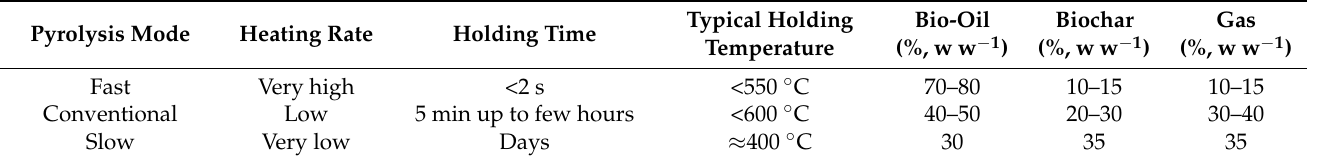
Table 3. Different pyrolysis modes. They differ from each other for the heating rate, holding time, and the number of different products